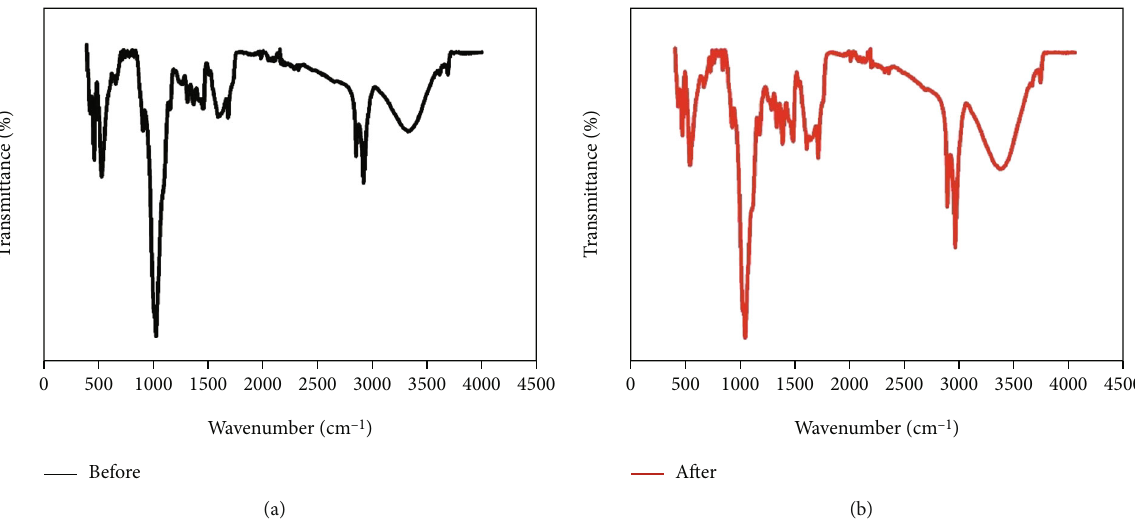
Figure 4: The FTIR spectra (a) prior to adsorption onto CL-KOH (b) following MG adsorption onto